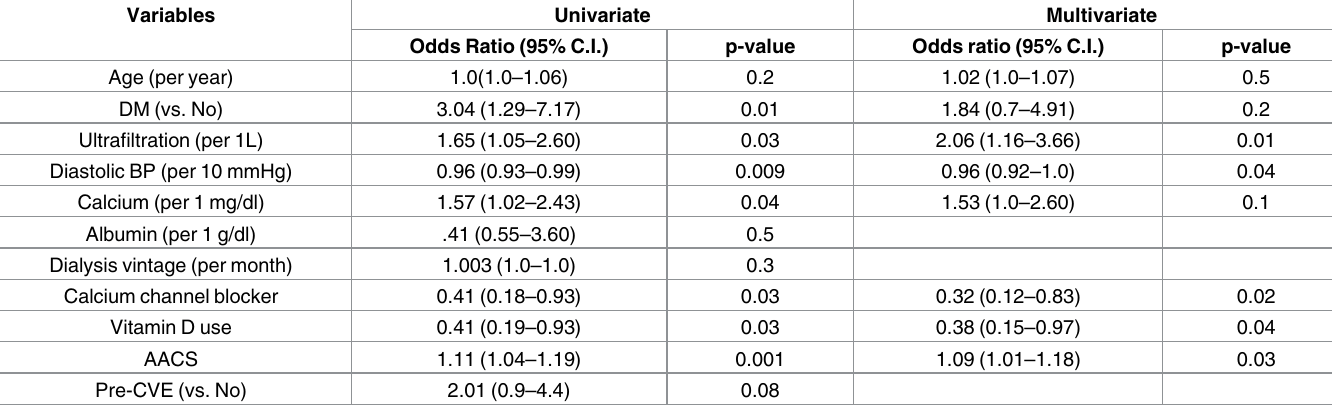
Table 2. Logistic models for associating factors of